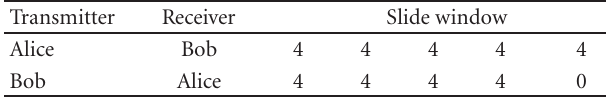
Table 1: An example of communication pattern